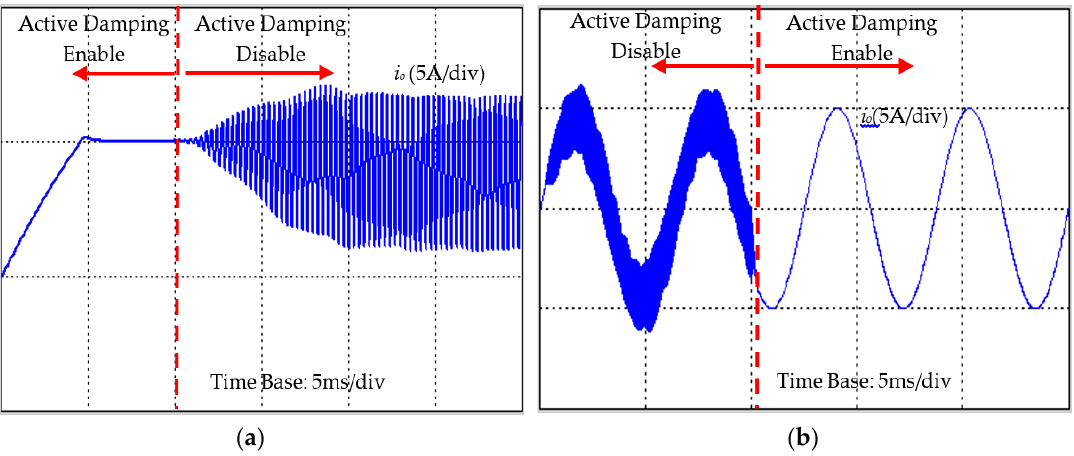
Figure 19. Simulation results of the output current with and without active damping method: ( a ) DC output current; ( b ) sinusoidal output current.